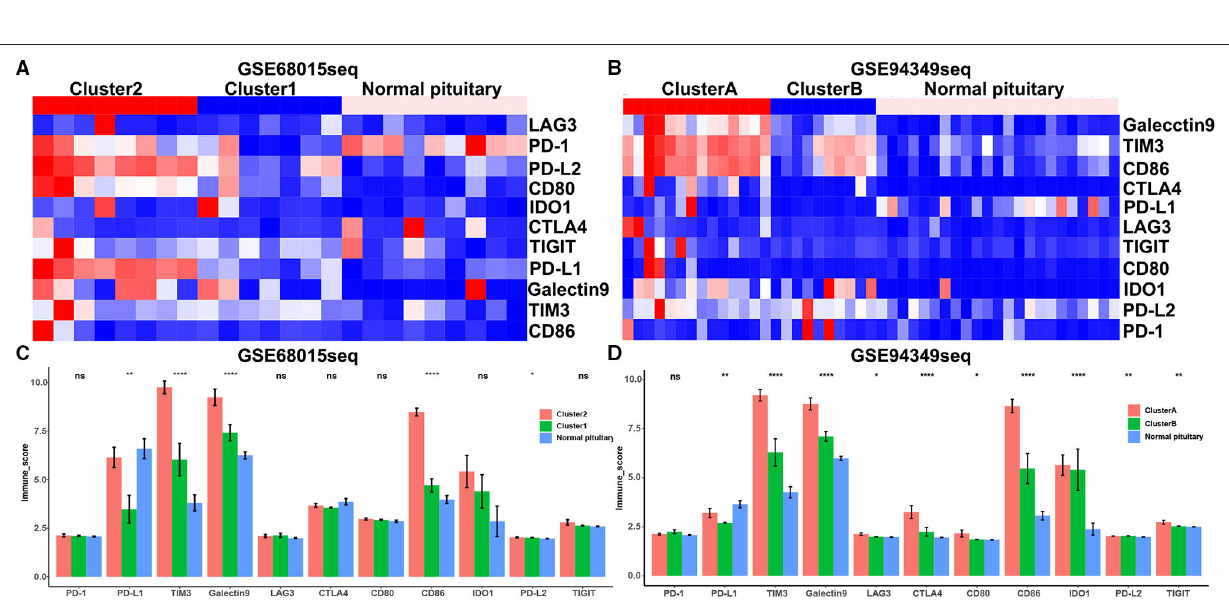
Frontiers in Neurology | www.frontiersin.org